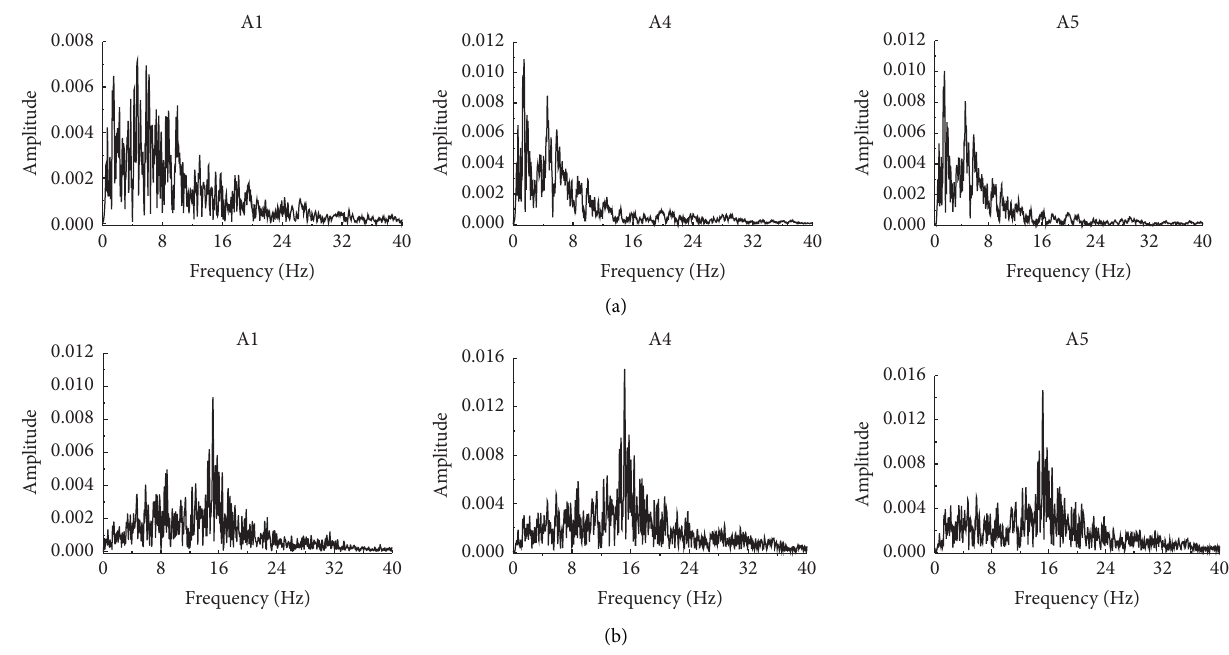
Figure 17: Acceleration Fourier spectrum of test 2 and test 5 soil layers under El-3 input. (a) Test 2. (b) Test 5. Table 8: Strain peak of structure under EL wave ( με ). Measuring point